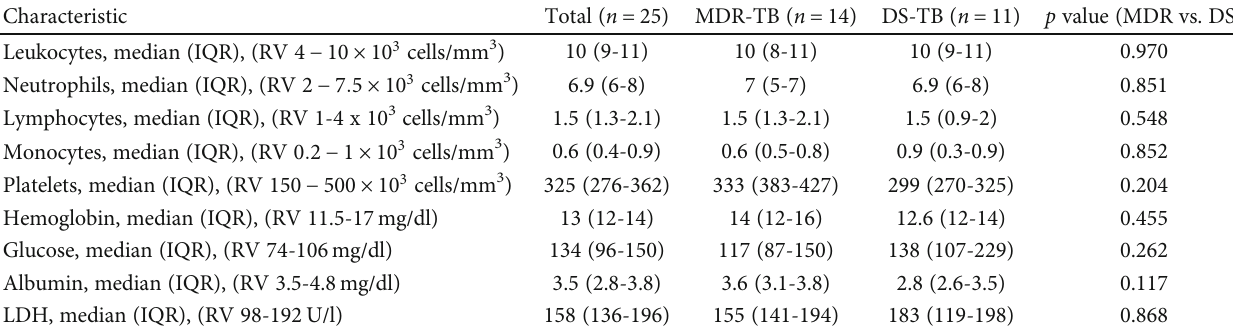
Table 2: Laboratory characteristics of the study